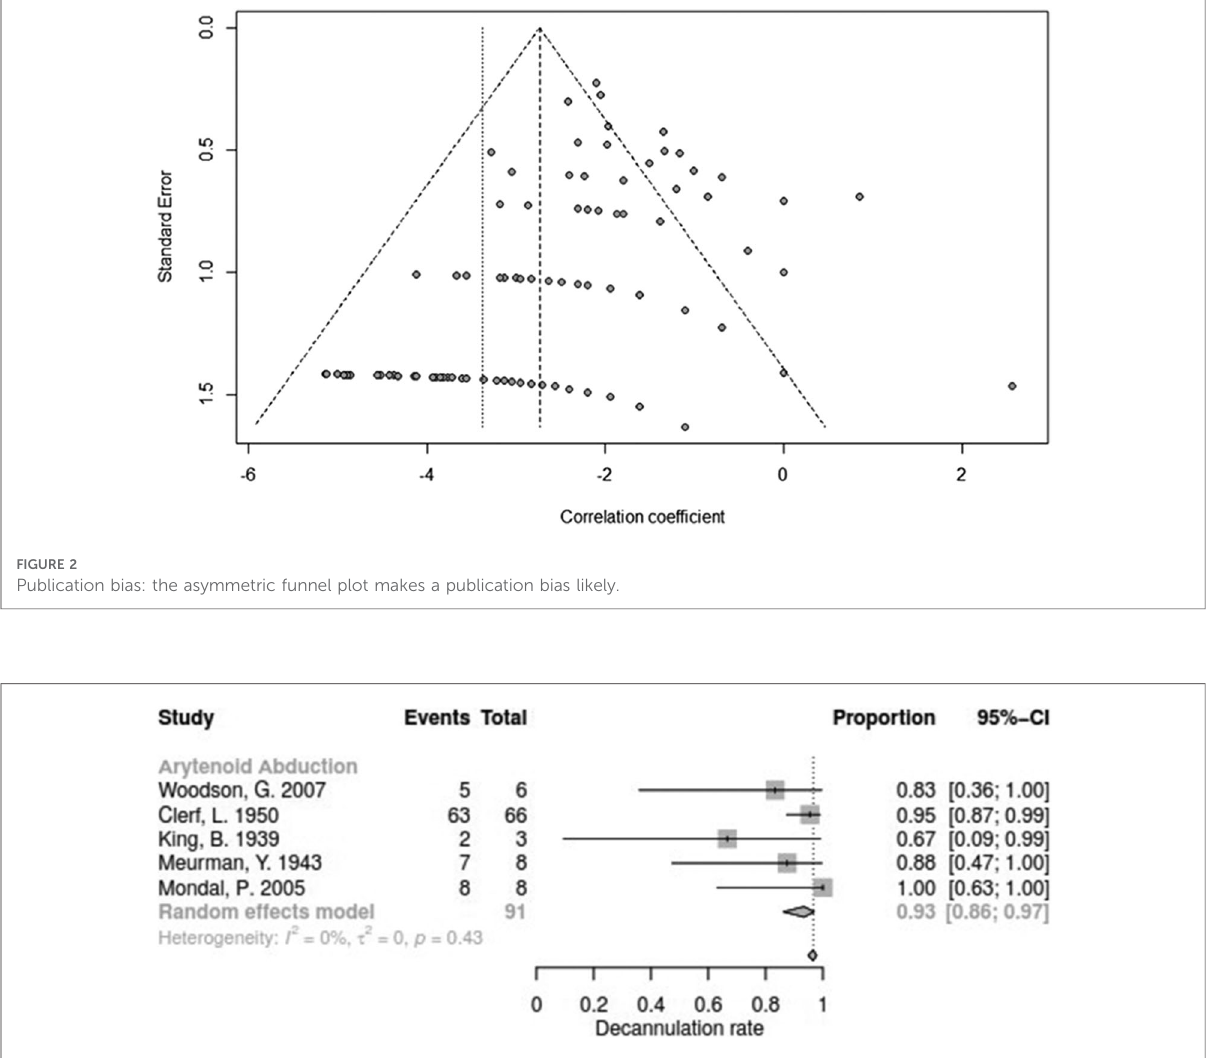
FIGURE 3 Forest plot of decannulation rates in studies on on arytenoid